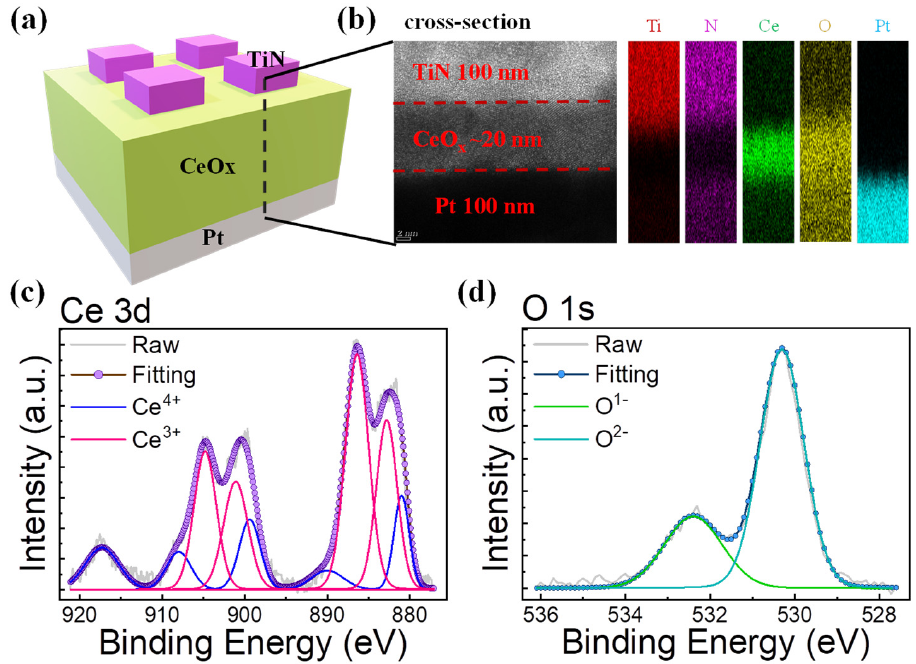
Figure 1. ( a ) Schematic of TiN/CeO x /Pt RRAM cells, ( b ) cross-sectional TEM image with EDS mapping that consists of Ti (red), N (purple), Ce (green), O (yellow), Pt (sky blue), and ( c ) Ce 3d and (d) O 1s XPS spectra of CeO x film.